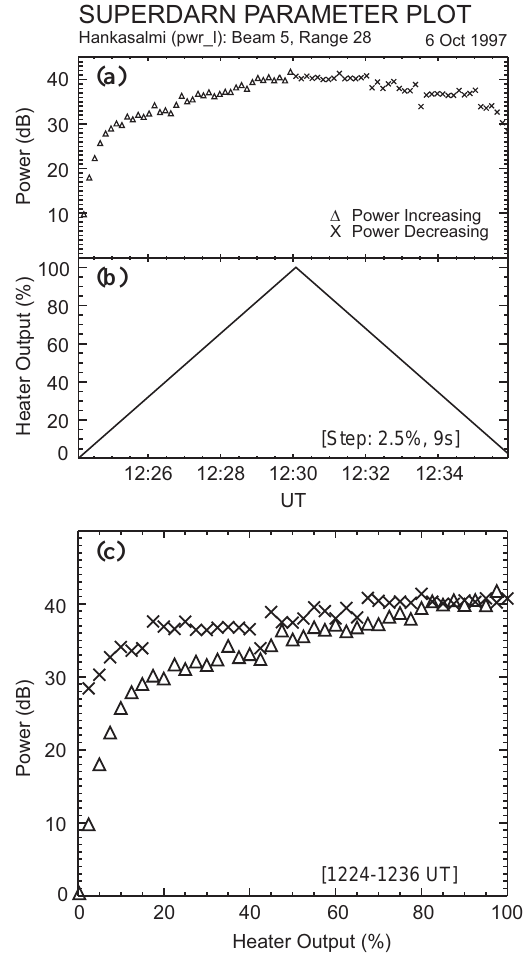
Fig. 4. (a) The received backscatter power from range 28 of beam 5 of the Hankasalmi radar during one cycle of the power stepping experiment shown in Fig. 3. (b) The power output of the heater during this cycle. Panel (c) shows the measurements in (a) as a function of the heater output (b) with the two halves of the cycle plotted separately to indicate the level of hysteresis between the up- and down-going parts of the